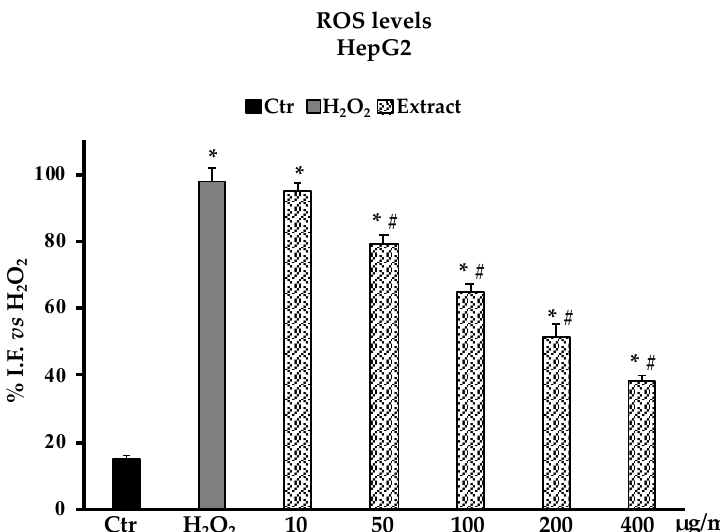
tive H 2 O 2 -induced stress revealed that pretreatments with the B. raimondoi extract at the different concentrations tested (10–400 µ g/mL), starting from 50 µ g/mL, were able to reduce the number of free radicals in cells in a dose-dependent manner. At 200 µ g/mL, the presence of ROS is reduced by about 50% with respect to non-pre-treated cells (Figure 5). In accordance with the above results, the investigation on non-protein thiol groups content after H 2 O 2 exposure in HepG2 cells pretreated with different concentrations of B. raimondoi (10–400 µ g/mL) showed a significative protective effect on thiol groups most represented Figure 4. LDH release in untreated HepG2 and CaCo-2 cells (Ctr) and treated for 24 h with the by glutathione (GSH) (Figure 6). At 400 µ g/mL, the extract was able to fully restore the extract (10 –1000 μg/mL). Values are the mean ± S.D. of five experiments in triplicate. Confidence intervalscalculated by two-way ANOVA test: * Significant vs. untreated control cells: p < 0.001. RSH content at level comparable to untreated control cells (Figure 6).